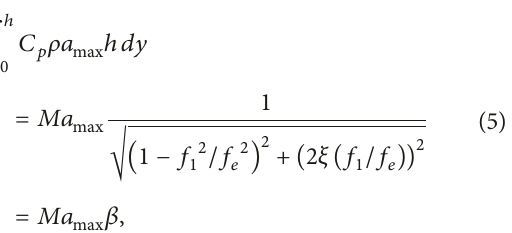
Figure 11: Comparison of the maximum hydrodynamic pressures on the wall at the vertical face due to waveforms EQ1 and EQ2: experimental and theoretical.